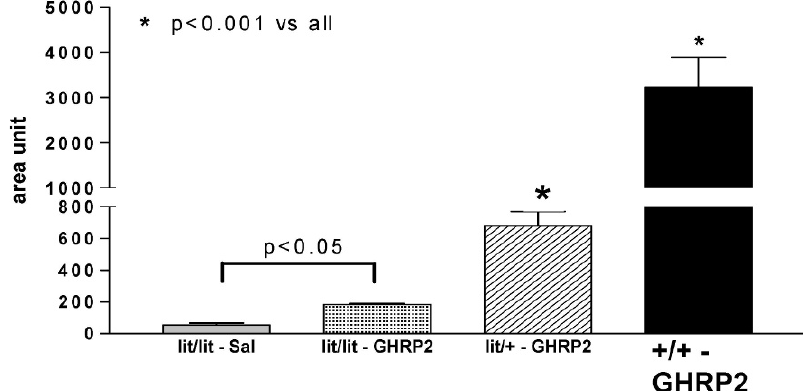
Figure 3 - Serum mGH responses to the acute administration of 10 m g GHRP-2 (or saline, SAL for lit/lit mice) in the lit/lit, lit/ + , and + / + mice expressed as the areas under the curve (AUCs). An arbitrary unit (ng/ml/min) was used to allow evaluation of the AUC. The animal experiments are as shown in Figure 2.